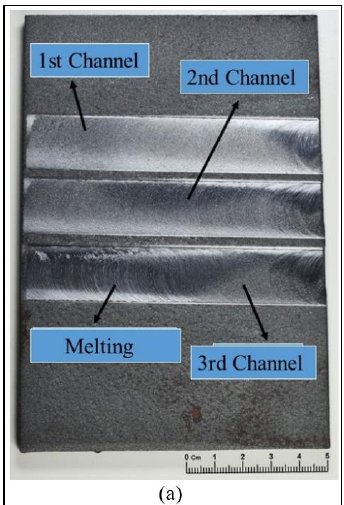
Figure 15a: Sample without sealant (nose radius 0,4 mm): (a) Machined surfaces.